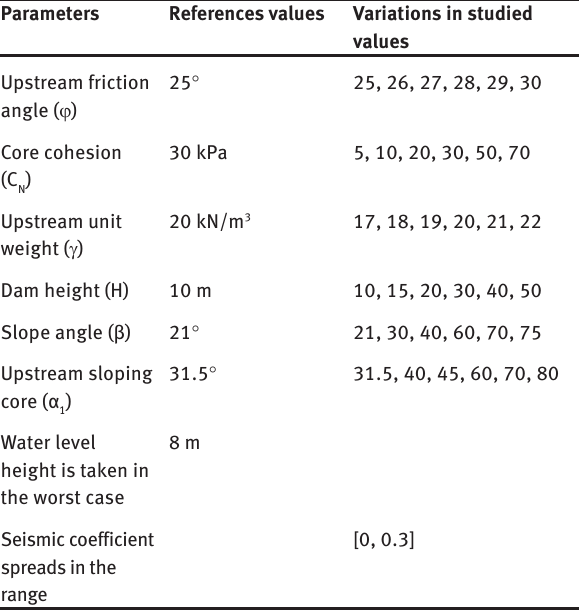
Table 1: Values of different parameters of the